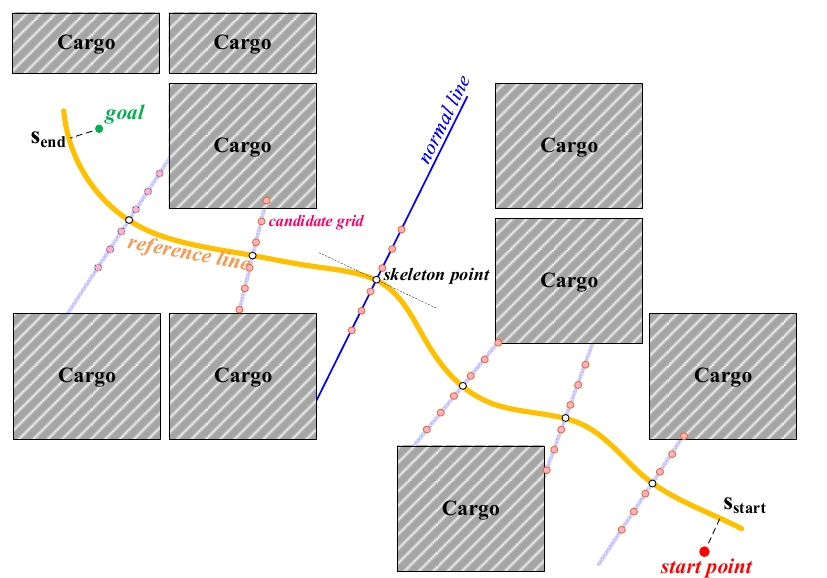
Figure 4. Schematics for a graph of sampled grids in DP